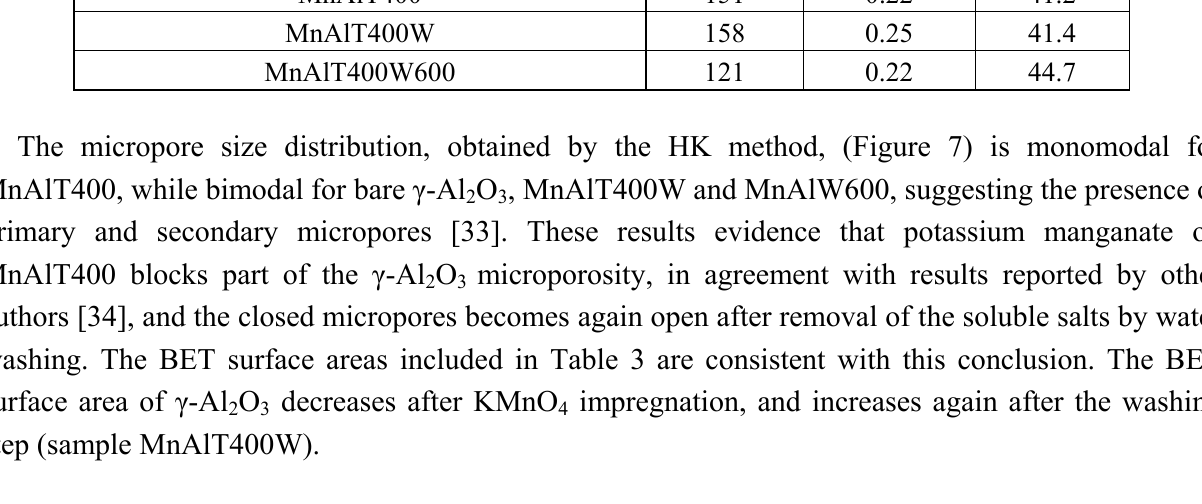
O ; ( b ) MnAlT400; 2 3